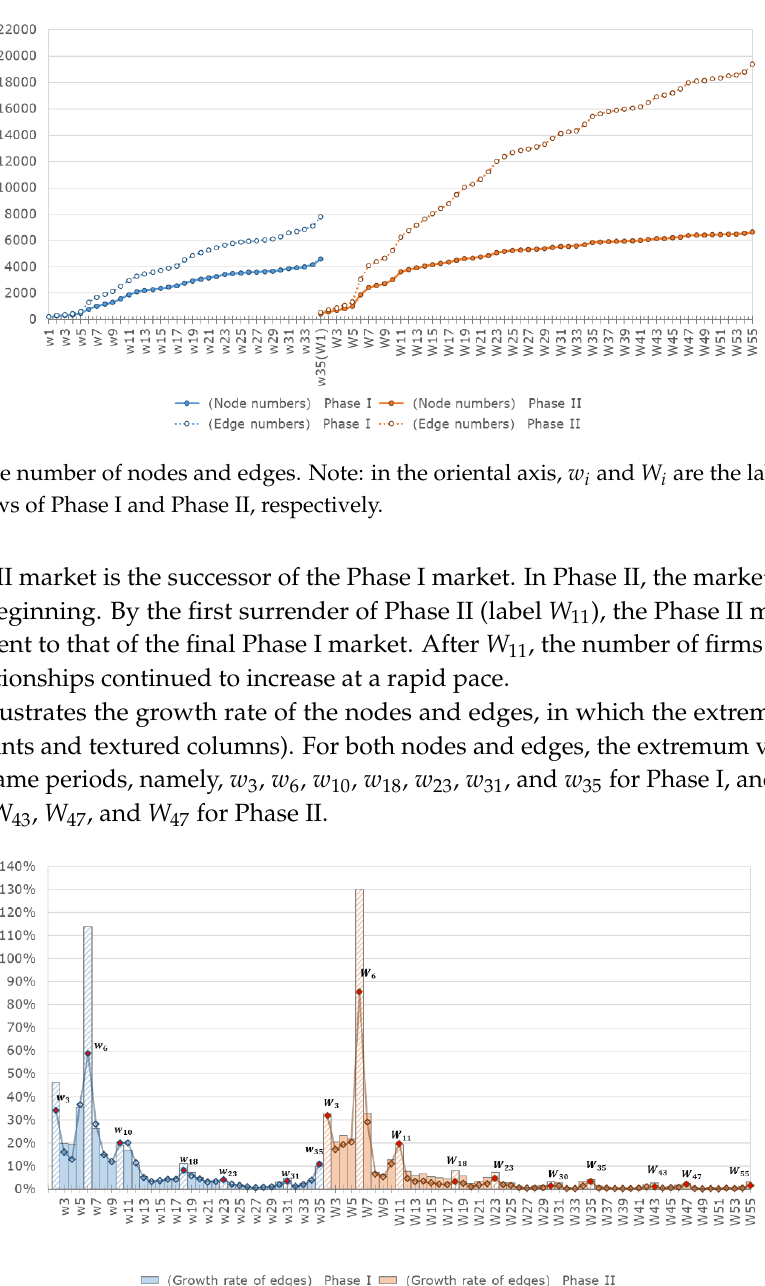
Figure 3. The growth rate of nodes and edges. Note: in the oriental axis, 𝑤 𝑖 and 𝑊 𝑖 are the labels for the time windows of Phase I and Phase II, respectively.